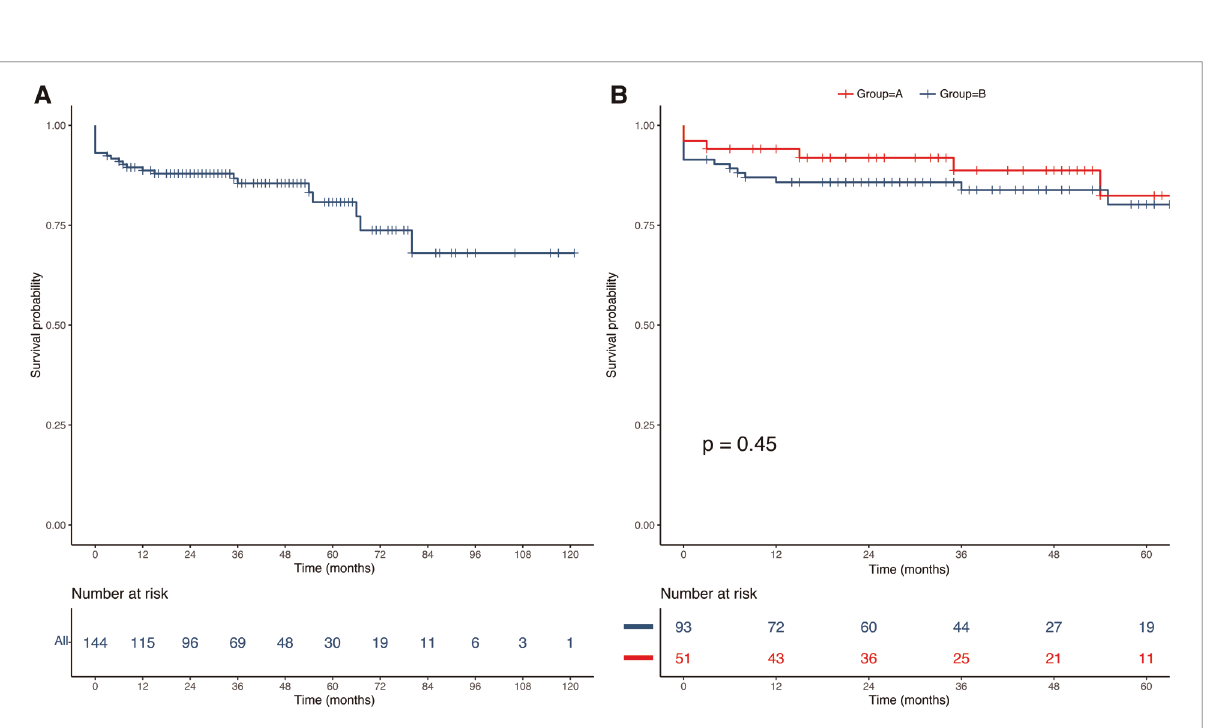
FIGURE 2 Kaplan – Meier curves of the estimated survival. ( A ) The overall mid-term survival curve for all of the patients; ( B ) The mid-term survival curve between group A and group B.